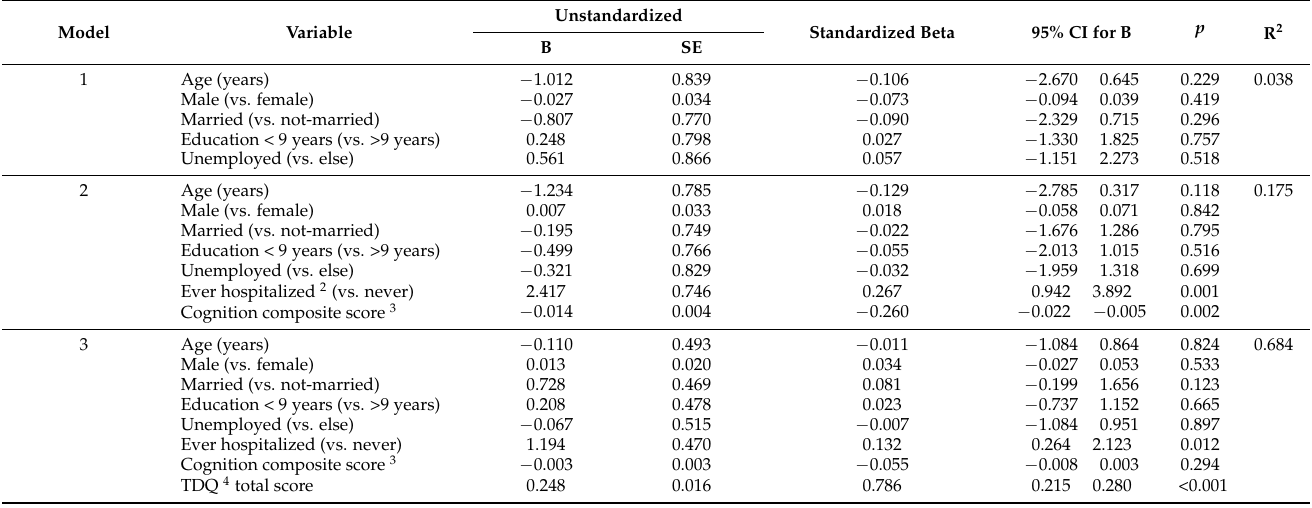
Table 5. Hierarchical multivariate linear regression predicting TCQ 1 scores in Group